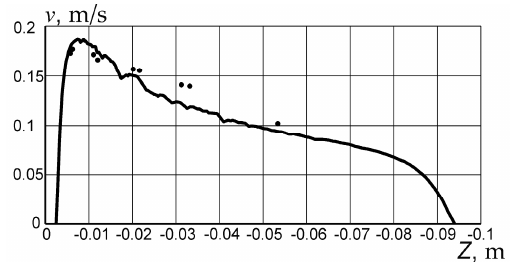
Figure 10. Graph of the velocity distribution over the bath depth along its axis ( —- calculation; • • experiment [13]).